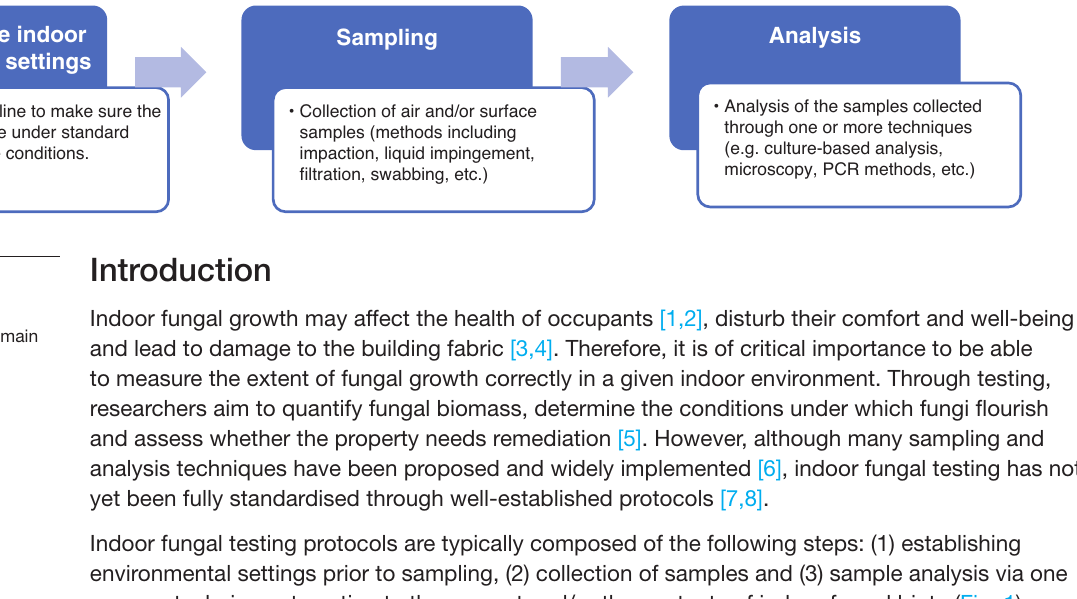
Table 1. Some examples of non-activated (a, b) and activated protocols (c) (length of line segments not indicative of the durations associated with their labelled activities relative to each other) Examples of different protocols Example studies Non-activated